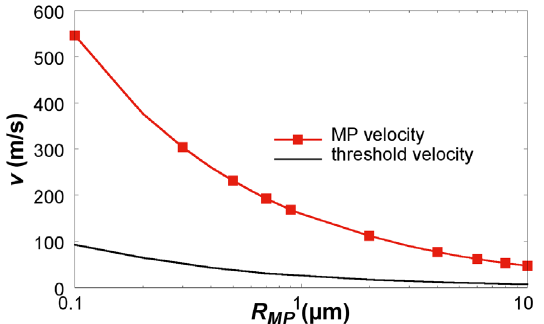
FIG. 13. Comparison of the velocity at the entrance of zone I ¼ 1 . 0 × 10 − 7 A and the threshold velocity obtained for for I tip Q for different R . cathode MP